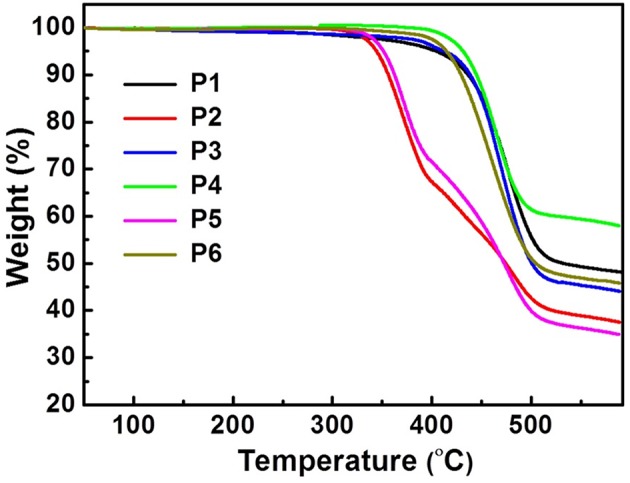
TGA curves of the CPONI-based polymers.